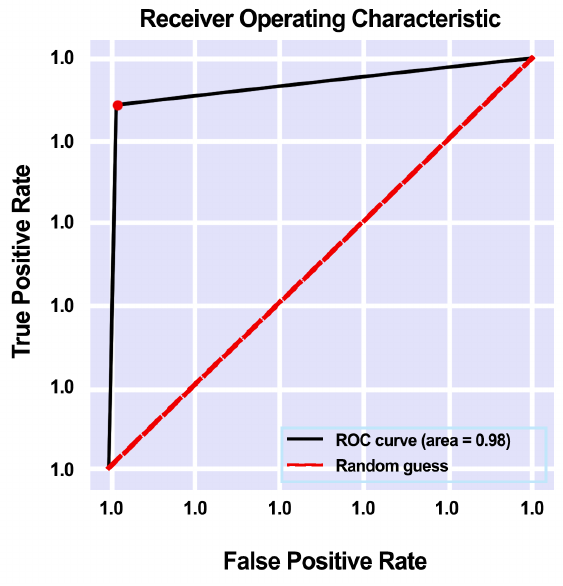
Figure 8. MobileNetV2 ROC curve on